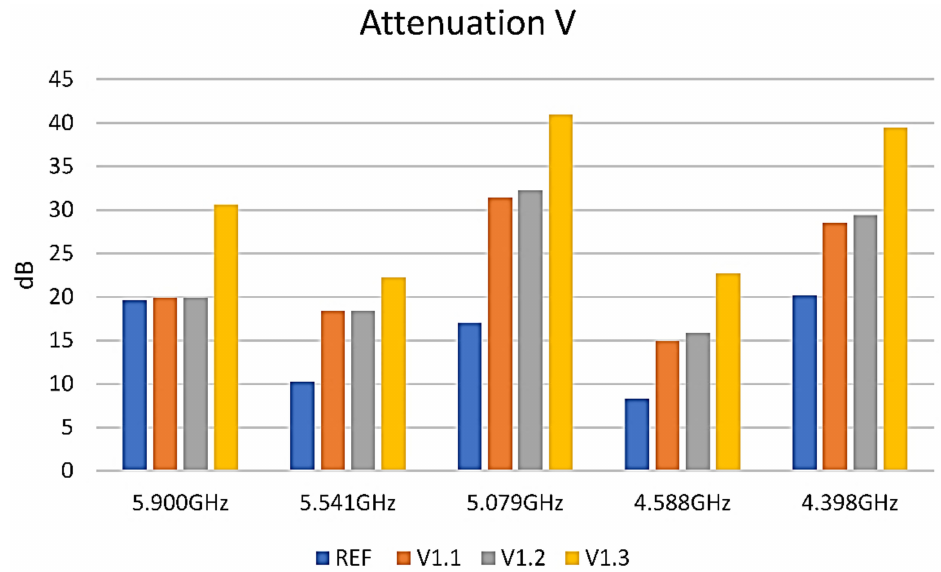
Figure 9. EMI-shielding measurements on V sample. Blue reference, orange 1 layer, grey 2 layers, yellow 3